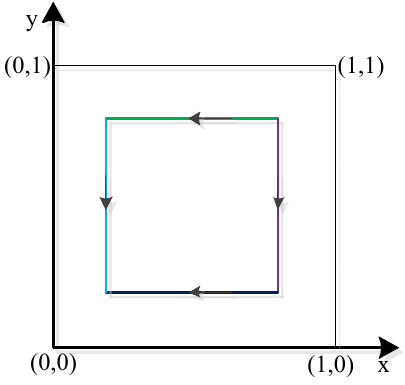
Figure 5. System evolution path of scenario 1.